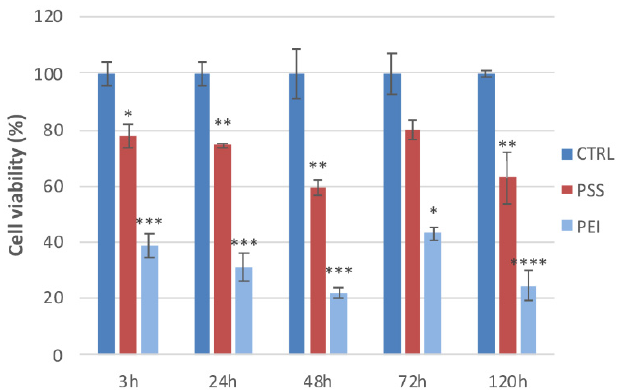
Figure 8. Cell viability: MSCs show different viability towards PSS and PEI after 3, 24, 48, 72, and 120 h. Results are presented as mean ± standard deviation (S.D.) of three independent experiments and normalized with respect to the control untreated cells (* p < 0.05, ** p < 0.01, *** p < 0.001, and **** p < 0.0001 versus CTRL, one-way ANOVA).